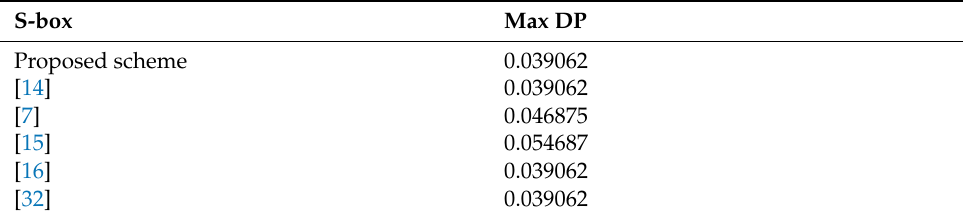
Table 10. Differential approximate probability (DP)